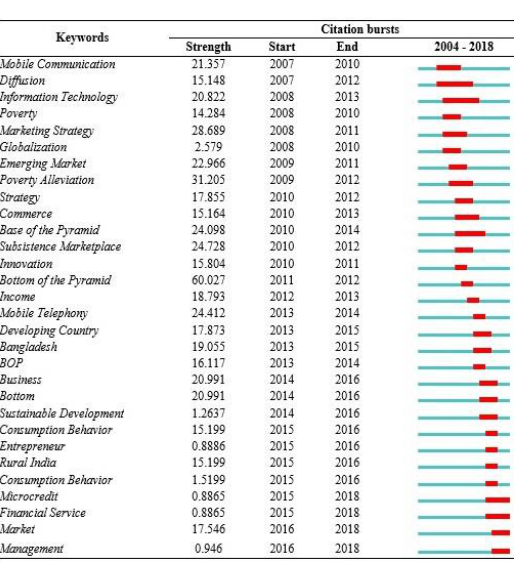
Table 3: Keywords with the Most Pronounced Bursts in Publications about the BoP